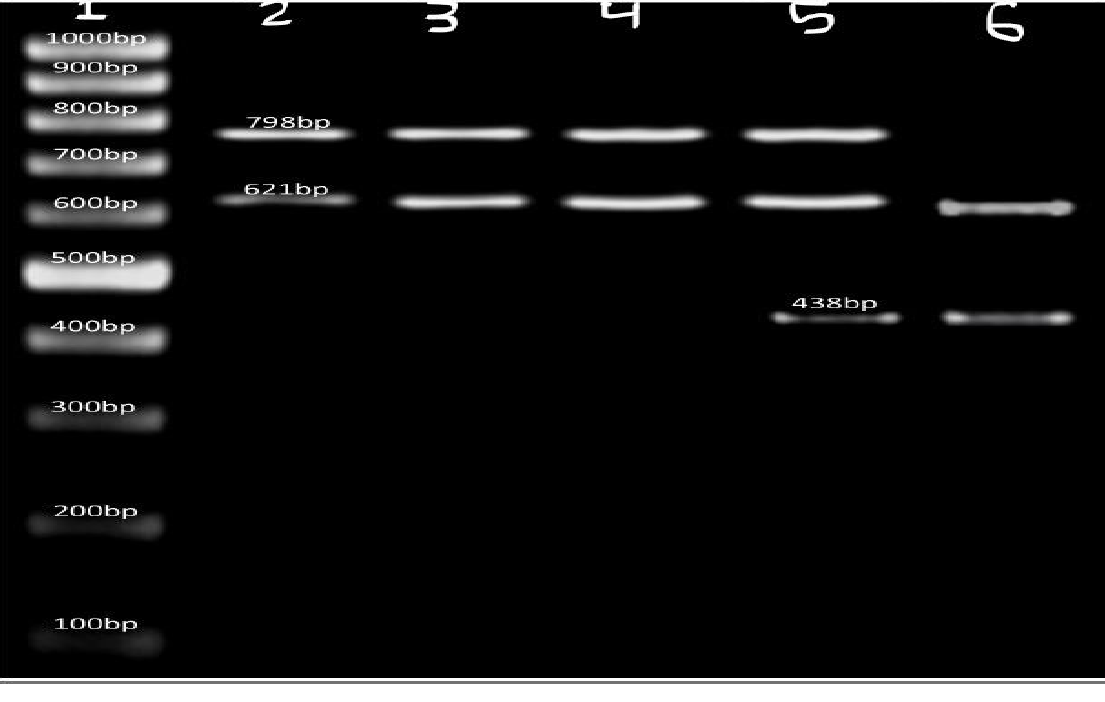
Figure 2. Agarose gel electrophoresis of multiplex PCR for ESBLs genes detection including bla TEM (860bp)